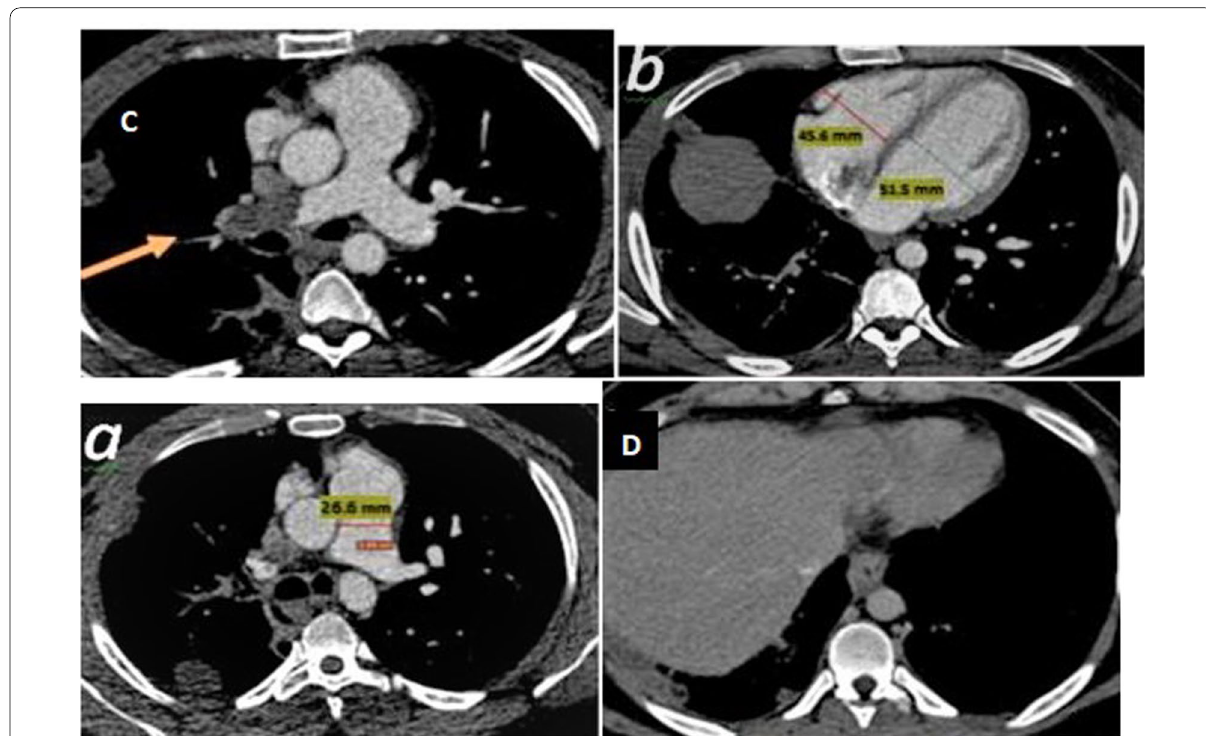
Fig. 4 a Axial CT images showing a non‑dilated PA (26 mm) and b RV/LV ratio < 1. c Axial CT images shows a large irregular filling defect (large thrombus,) totally occluding the right main pulmonary artery (arrows) d axial Ct image showing no contrast reflux in the hepatic